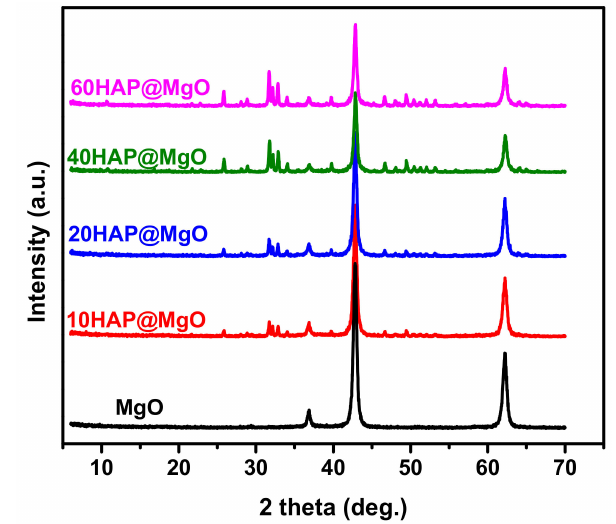
Figure 1. The X-Ray Diffraction (XRD) patterns of the prepared HAP@MgO composites as compared to the neat mesoporous